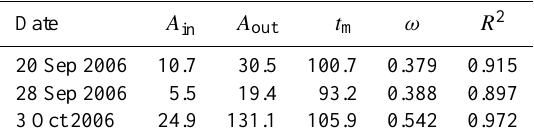
Table 3. Results of the impulse–response analysis for three dis- charge events in 2006. A in : area under input signal at site GS-RU; A out : area under output signal at site GS-RD; t m : mean transit time; ω : variance of time; R 2 : coefficient of determination from impulse– response function.